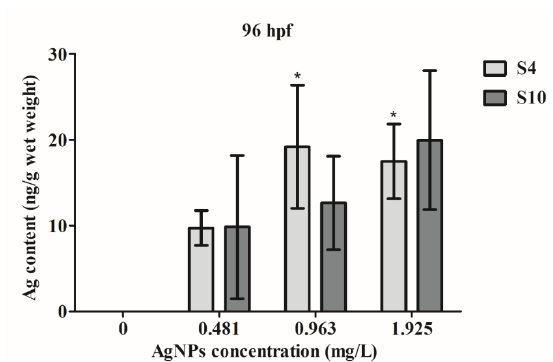
Figure 4. Silver content in wet weight of fish embryos exposed to AgNPs from 4 to 96 hpf. Values represent mean ± standard error. * significant difference between samples and the control groups using one-way ANOVA. * p < 0.05. n = 4. Int. J. Mol. Sci. 2020 , 21 , x FOR PEER REVIEW